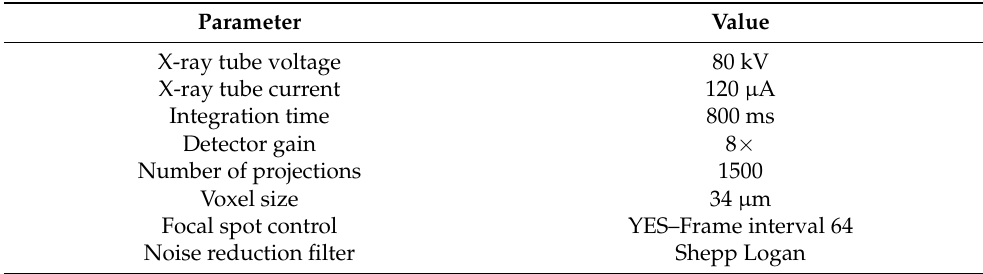
Table 1. Summary of CT measurement